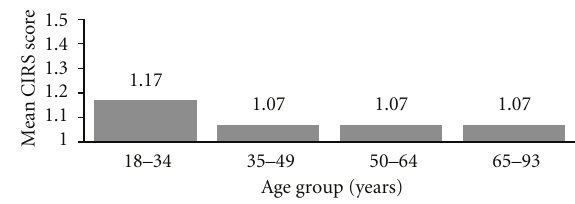
Figure 1: Mean score on 9 items of the CIRS (0–4 point scale) according to age group. one-way ANOVA P value across age groups = 0.04.